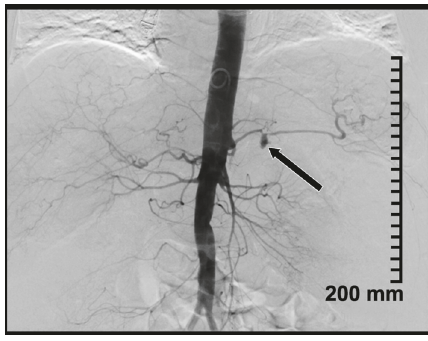
Figure 4: Bleeding splenic artery pseudoaneurysm seen on